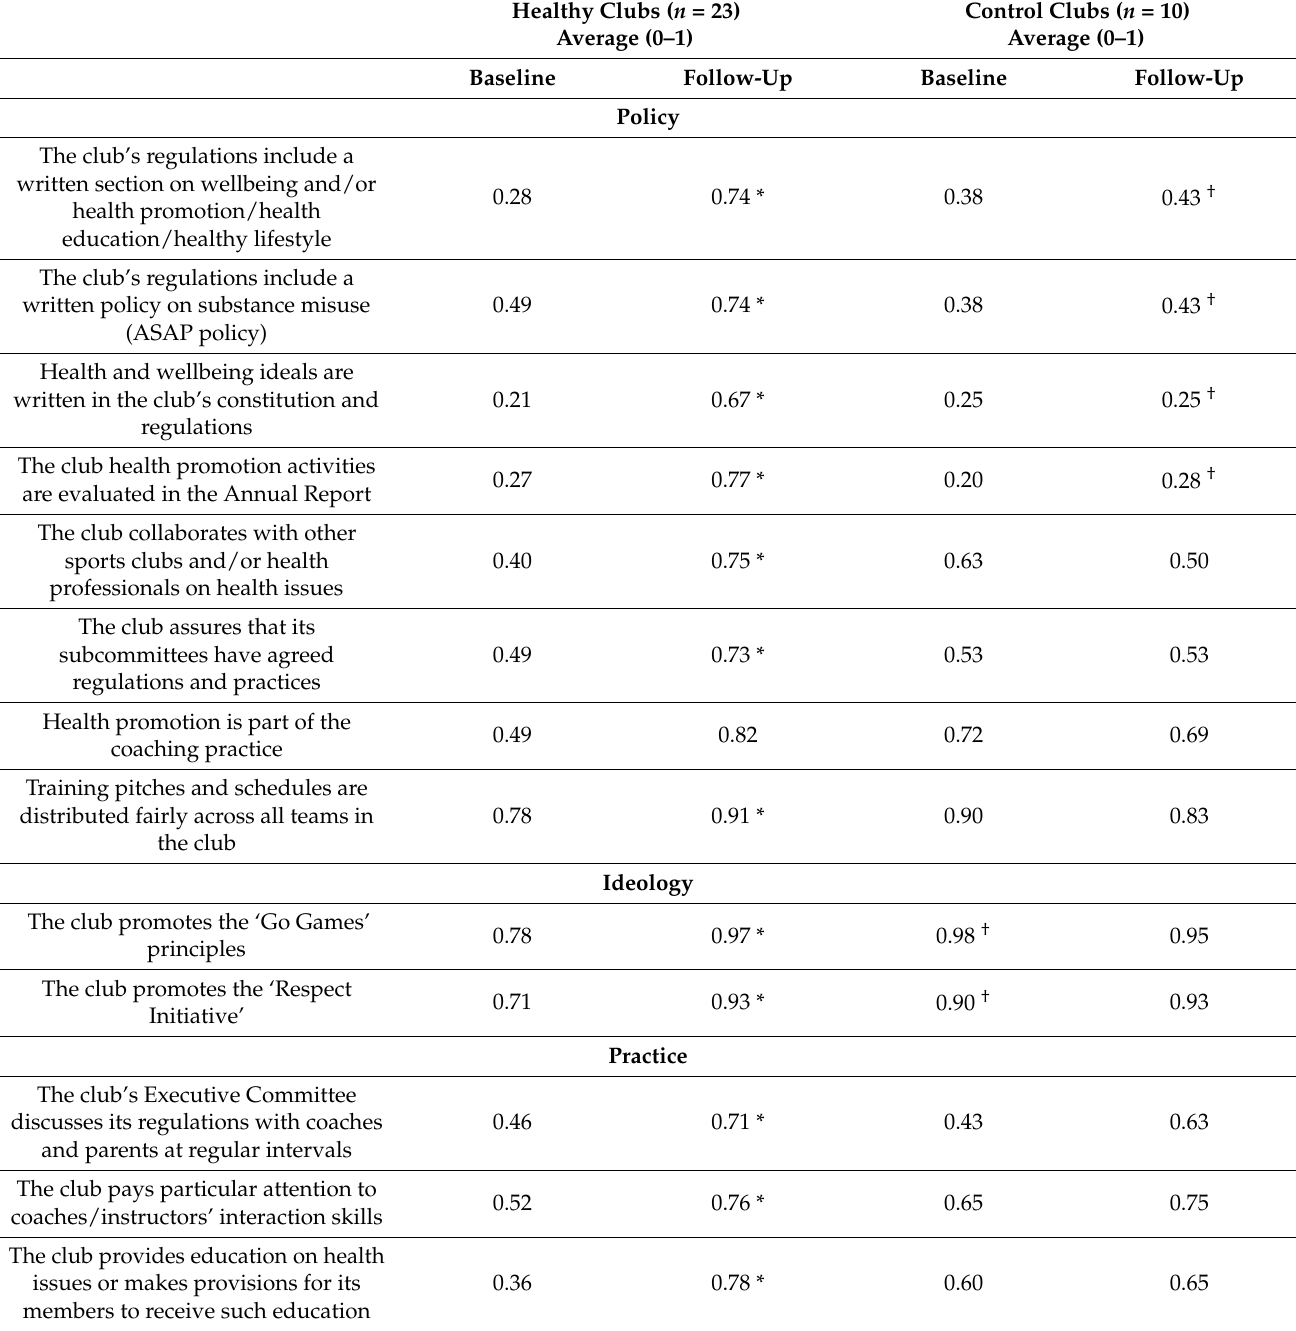
Table 2. Sub-components of health promotion orientation for Healthy and Control